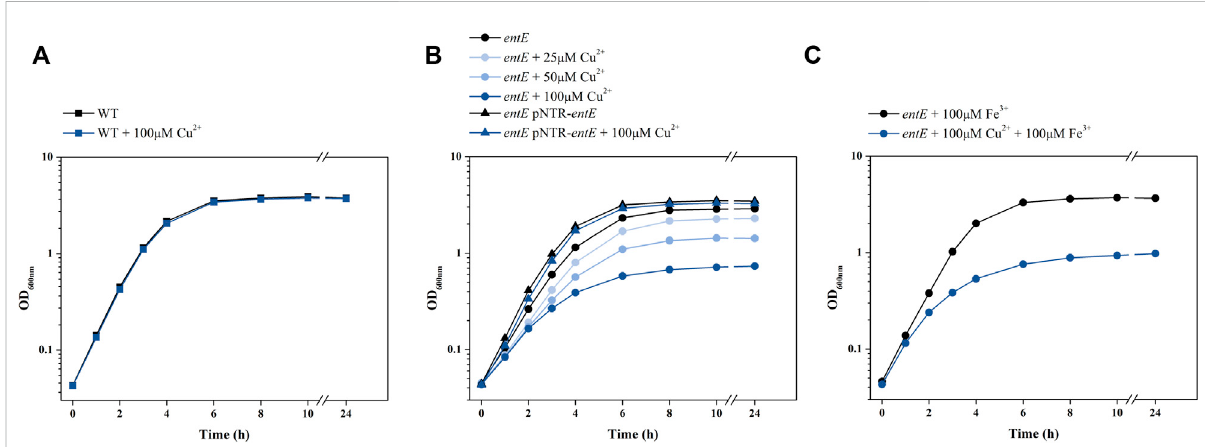
FIGURE 1 Effectofcopperon E.coli growth.Growthcurvesobtainedfor E.coli wild-type(WT), entE mutantand entE mutantcomplementedwithplasmid pNRT- entE . (A) Effect of copper addition on WT. (B) Effect of different copper concentrations on growth of entE and entE complemented with pNRT- entE . (C) Effect of simultaneous copper and iron supplementation on entE growth. Strains were cultured for 18 h in liquid aerated minimal M9 medium supplemented with 0, 25, 50, and 100 μ M of CuSO 4 . Experiments were done at least in